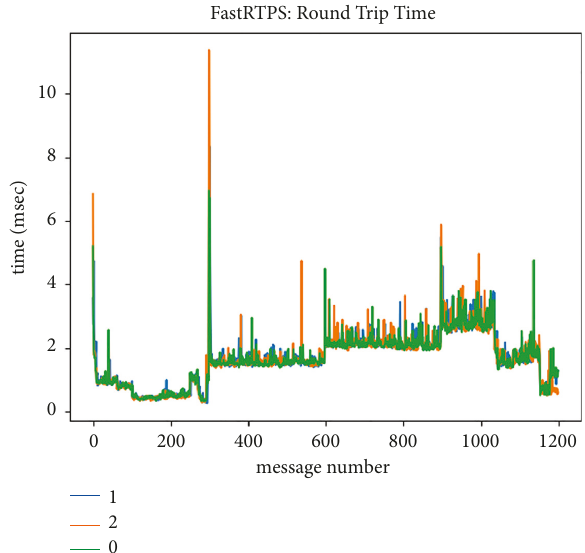
Figure 18: PahoMQTT +Mosquitto broker RTT with three communicating process pairs.